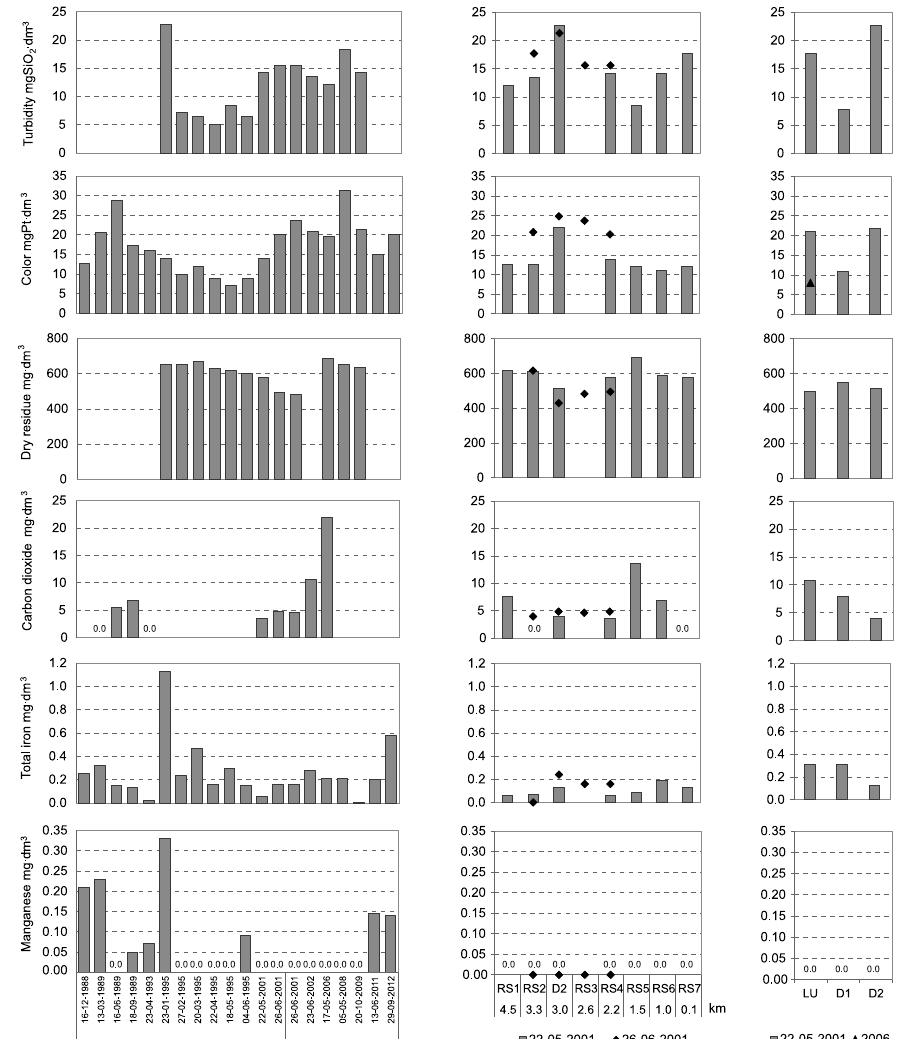
Fig. 13. Additional quality indicators: turbidity, color, dry residue, carbon dioxide, total iron and manganese. Explanation: A – Różany Strumień (1988–2012); B – downstream of the Różany Strumień – kilometres from the estu - ary (2001); c – lake Umultowskie (2001, 2006) and Różany Strumień tributary